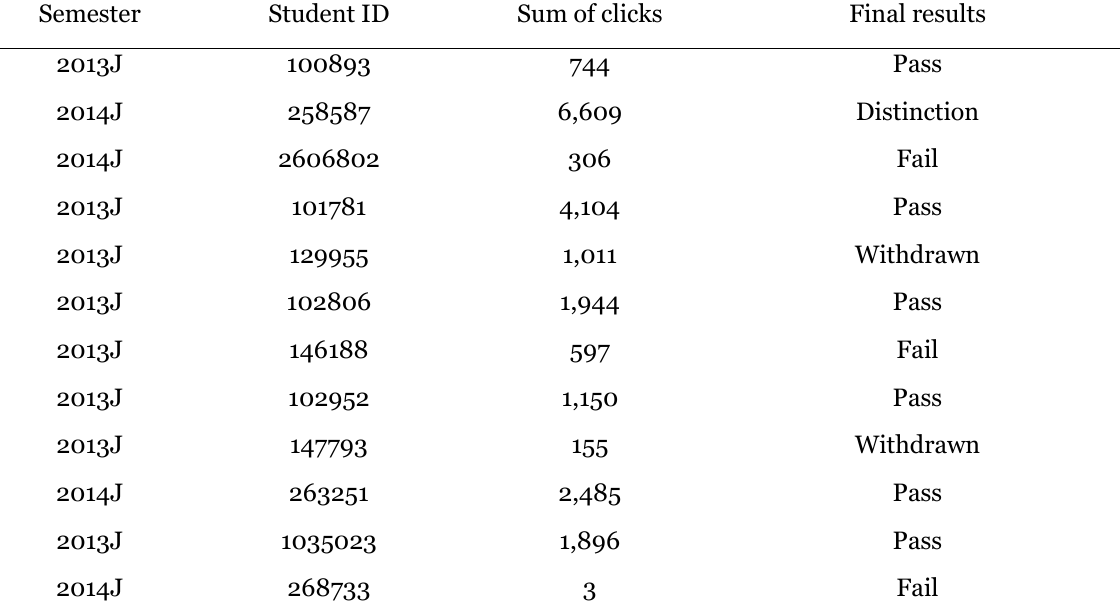
Summary of the Preprocessed Sample OULAD Dataset for Module